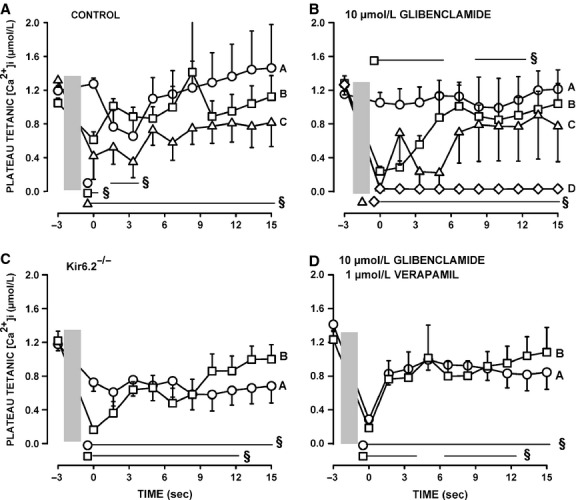
Recovery plateau tetanic [Ca2+]i among fiber groups. (A) Changes in plateau tetanic [Ca2+]i following fatigue for the three control groups as shown in Figure5A–C; (B) the same for glibenclamide-exposed fibers as shown in Figure6A–D; (C) for Kir6.2-/- fibers in Figure7A–C; (D) for glibenclamide- and verapamil-exposed fibers as shown in Figures8A–B. During the recovery period, fibers were stimulated every 100 sec. Gray vertical box represents the 3 min fatigue period. Vertical bars represent the SE of the number of fibers as indicated in Figures8. §Mean plateau tetanic [Ca2+]i was significantly different from the prefatigue mean value (Time −3 min). ANOVA and L.S.D., P < 0.05.